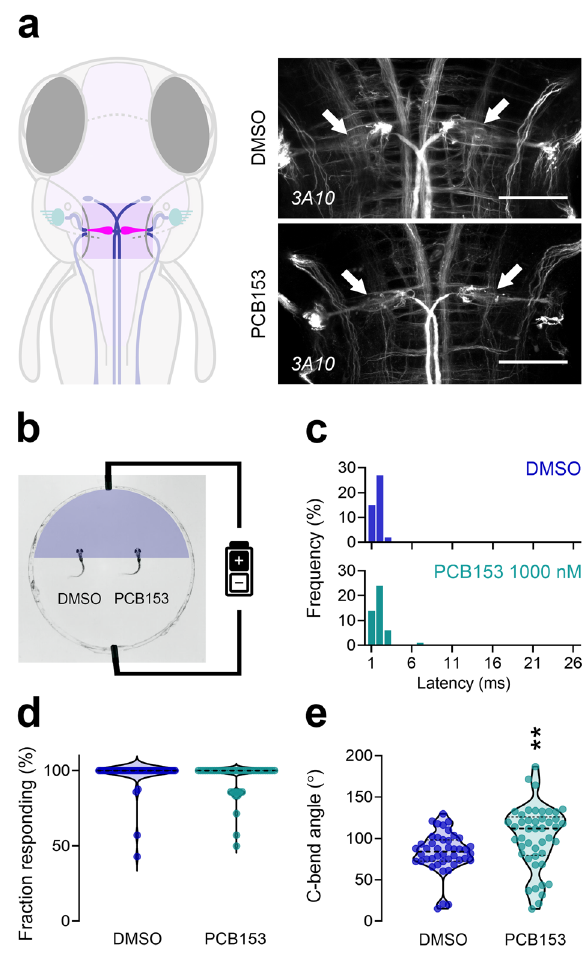
Fig. 4 Effect of PCB153 on presence and function of the Mauthner cells. a Diagram indicating localization of Mauthner cells in the hindbrain and brain tissue immunostaining with anti-neuro fi lament 3A10 antibody labeling reticulospinal neurons in control and PCB153 treated larvae at 6 dpf (ventral view). Mauthner (arrow) cells were present in all brain tissues (DMSO: n = 23, PCB153: n = 21, biologically independent samples). Scale bar = 50 µ m. b Diagram of electrical stimulation performed to assess the functionality of Mauthner cells. Both DMSO ( n = 44) and PCB153 ( n = 45) treated larvae show similar c latency to electrical stimulation and d response frequency, indicating that the Mauthner cells are present and functional, e while the C-bend angle in PCB153 exposed larvae was increased (Welch ’ s t -test, ** p = 0.0091). All data points are biologically independent samples (one value representing the mean of seven consecutive electric fi eld pulses) from three independent experiments and mean ± SD are shown in the plots. Mann – Whitney test was used for statistical analysis in ( c ), binomial GLM in ( d ), and unpaired two-tailed t -test with Welch ’ s correction in ( e ). Dashed lines represent median and quartiles and asterisks indicate signi fi cant differences to